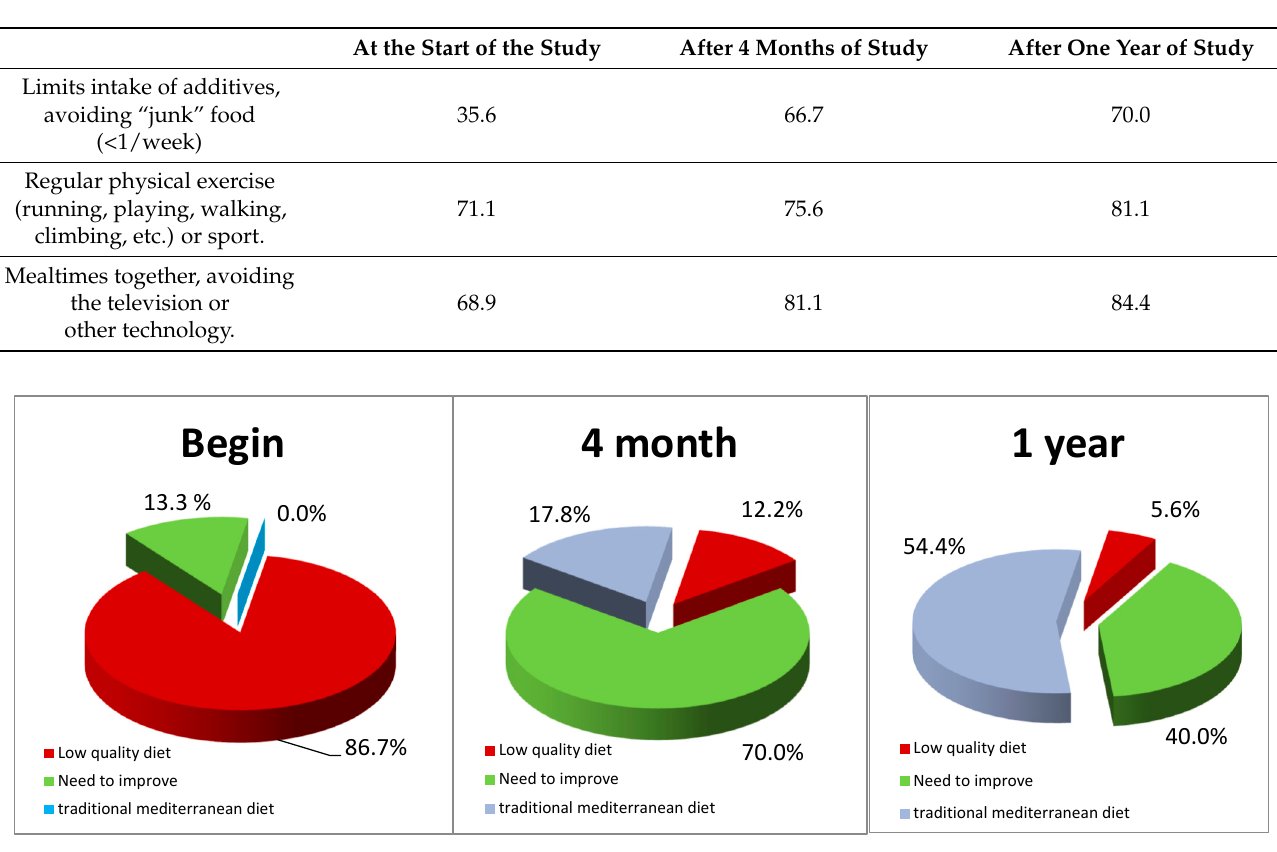
Figure 1. Evolution of quality of diet, measured using TMD Test.